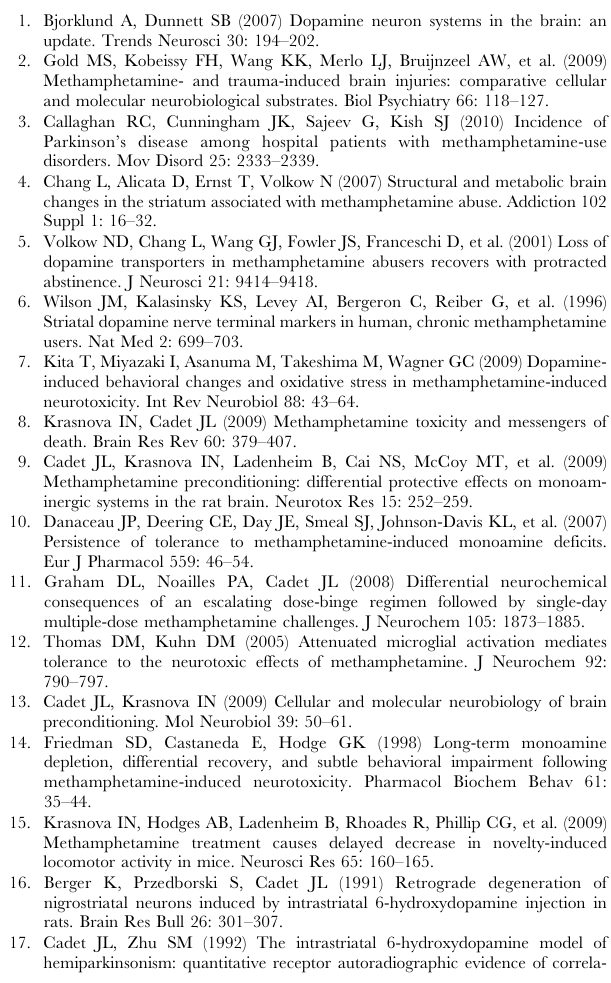
Table S1 Dosing schedule used for METH escalating dose pretreatment and challenge METH